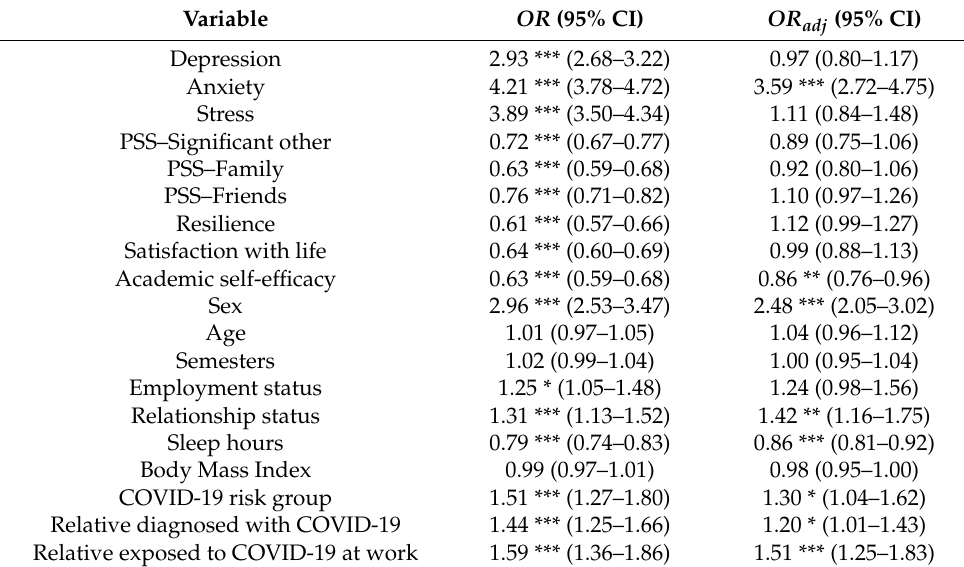
Table 2. Predictors of Somatic Symptom